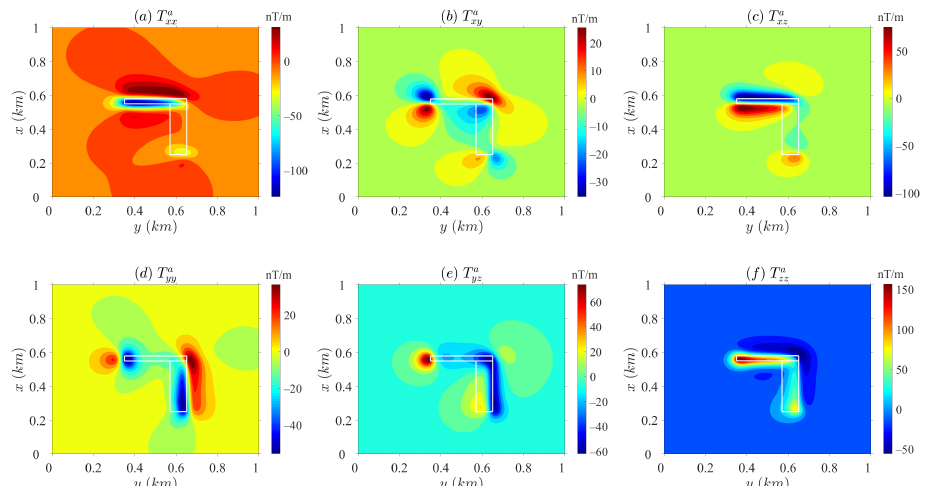
Figure 13. Surface anomalous magnetic gradient fields due to the two-dike model with susceptibility of 3